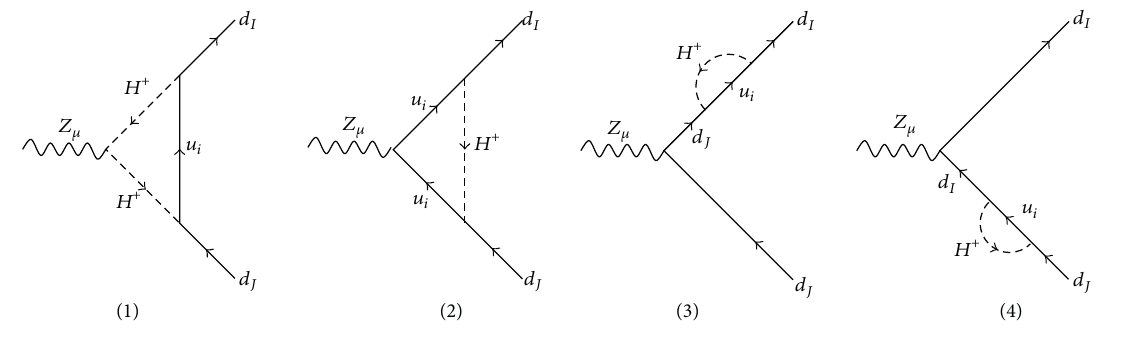
Figure 1: One-loop diagrams for corrections to 𝑍 → 𝑑 𝐼 𝑑 𝐽 from charged Higgs loops. Similar diagrams with 𝑊 − 𝑡 󸀠 loops contribute as well.